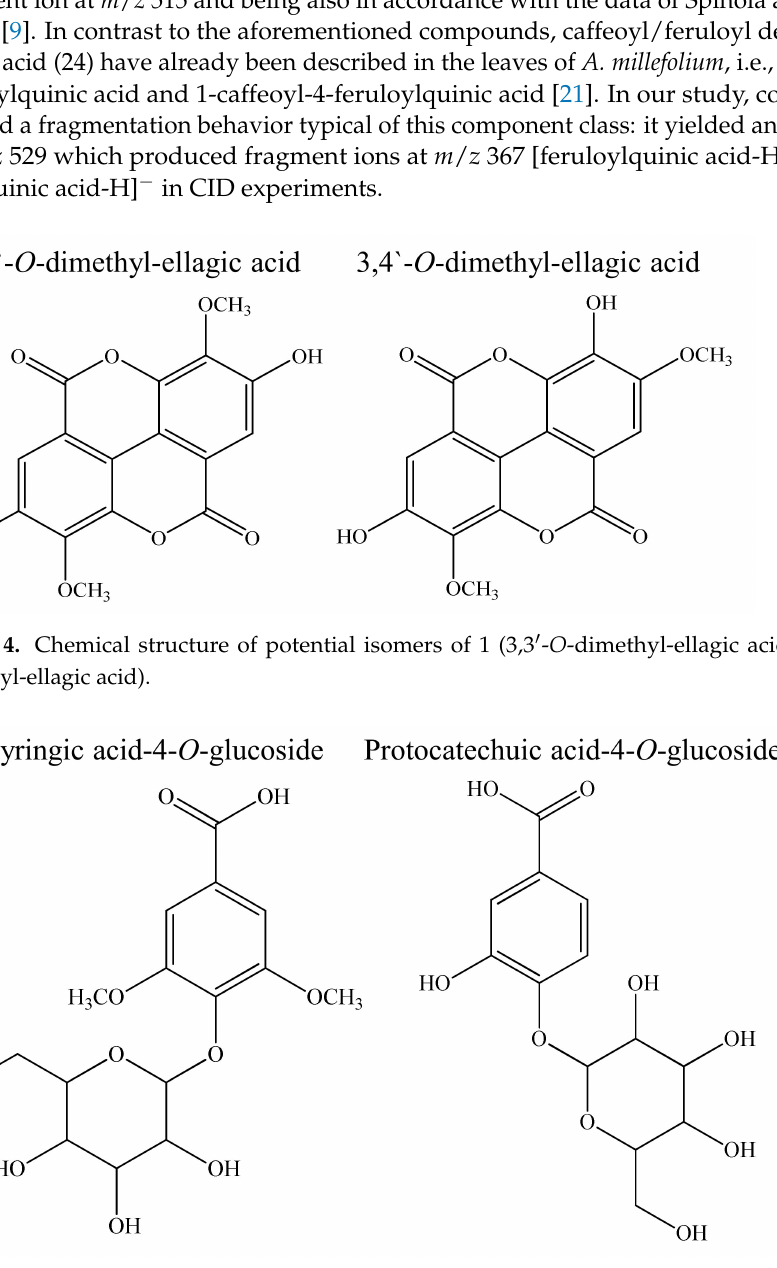
Figure 5. Chemical structures of potential isomers of 2 and 3 (syringic acid-4- O -glucoside and protocatechuic acid-4- O